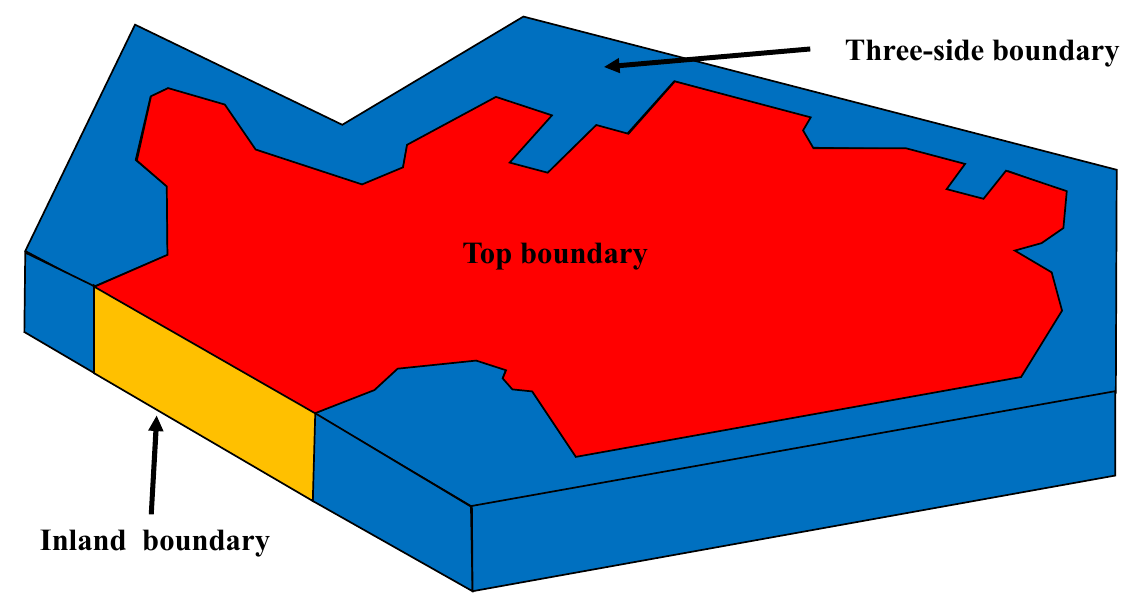
Figure 5. Partial boundaries of the model.